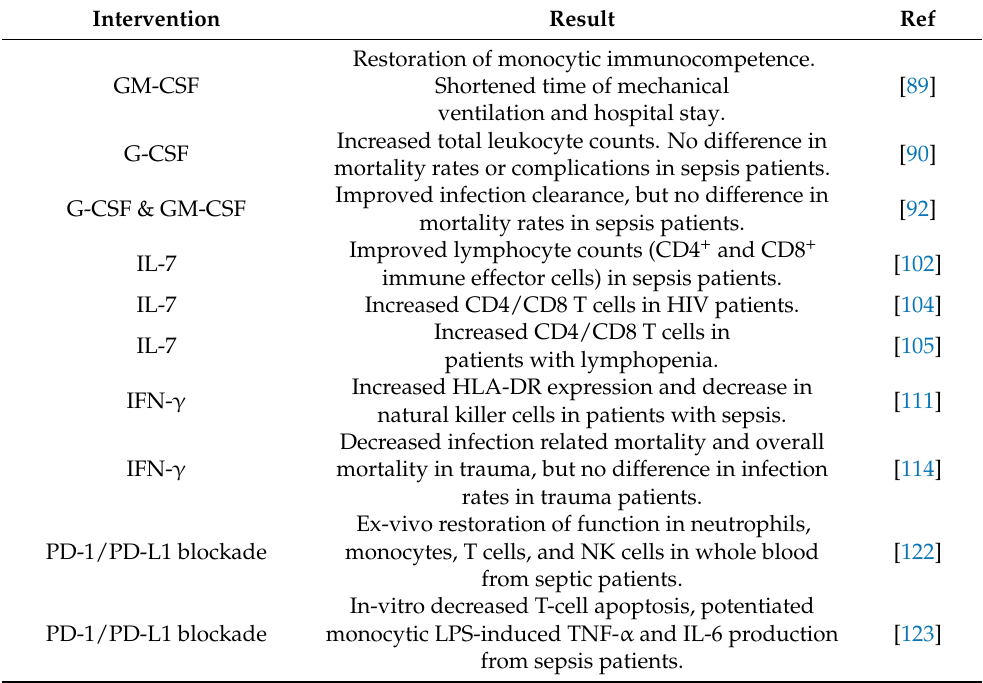
Table 1. Summary of select immunotherapy studies in sepsis or